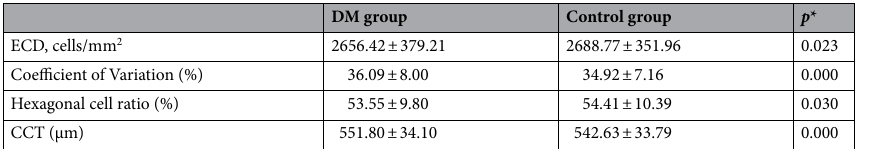
Table 2. Comparison of the mean values of ECD, CV, hexagonality, and CCT of diabetic eyes and controls across all ages (mean ± SD). ECD Endothelial cell density, CV Coefficient of variation, CCT Central corneal thickness. * p value by independent